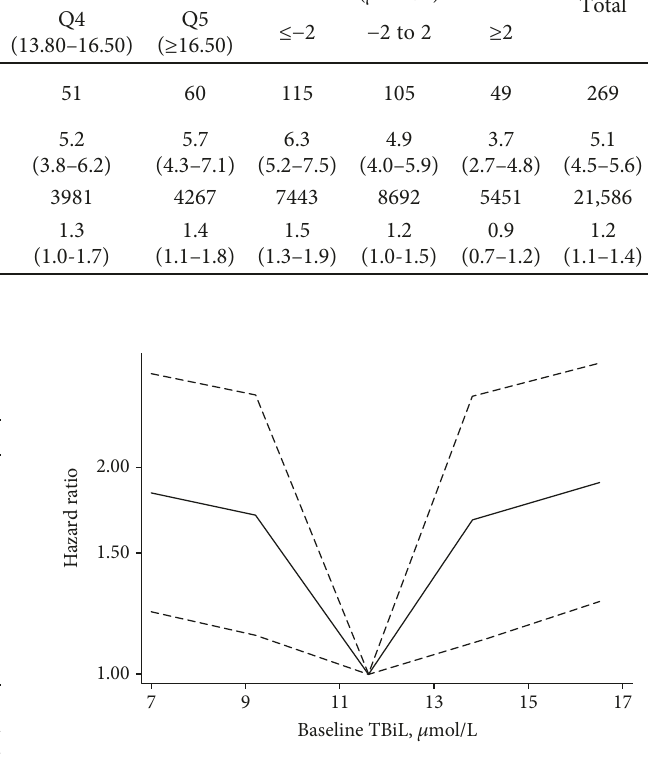
Figure 2: HRs of follow-up TBiL changes for DR incidence according to baseline TBiL